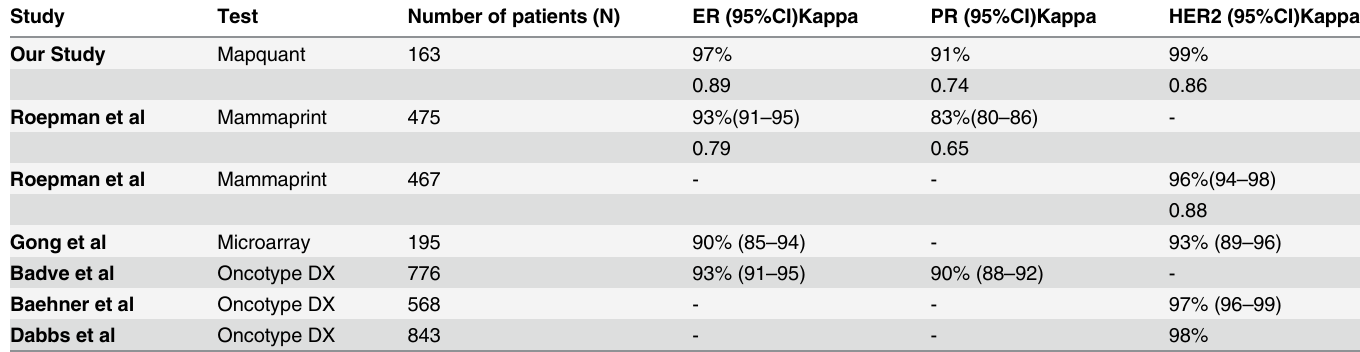
Table 3. Concordance (%) of the main Gene Expression Assays in determining ER, PR and HER2 status compare to corresponding IHC reference.